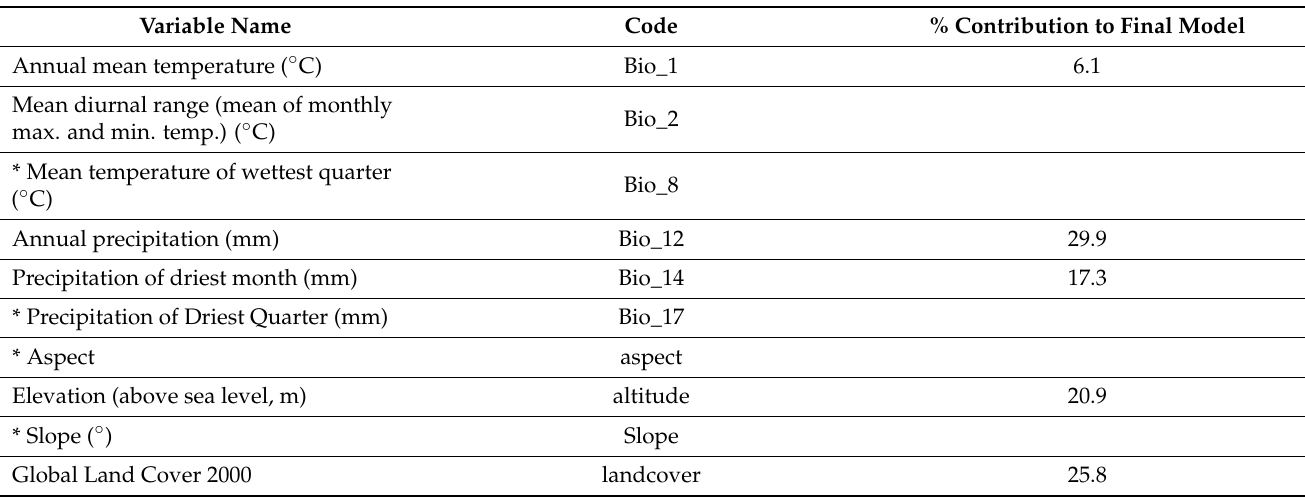
Table 1. Climatic, topographic and land cover predictor variables used in modelling and their percent contribution in the final